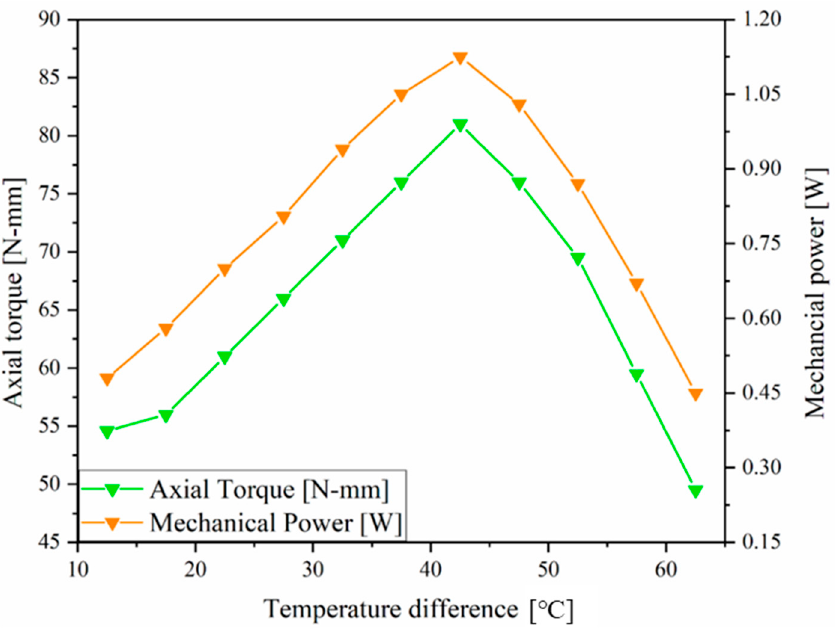
Figure 9. Effect of temperature difference on axial torque and mechanical power of the cylindrical thermomagnetic heat engine.